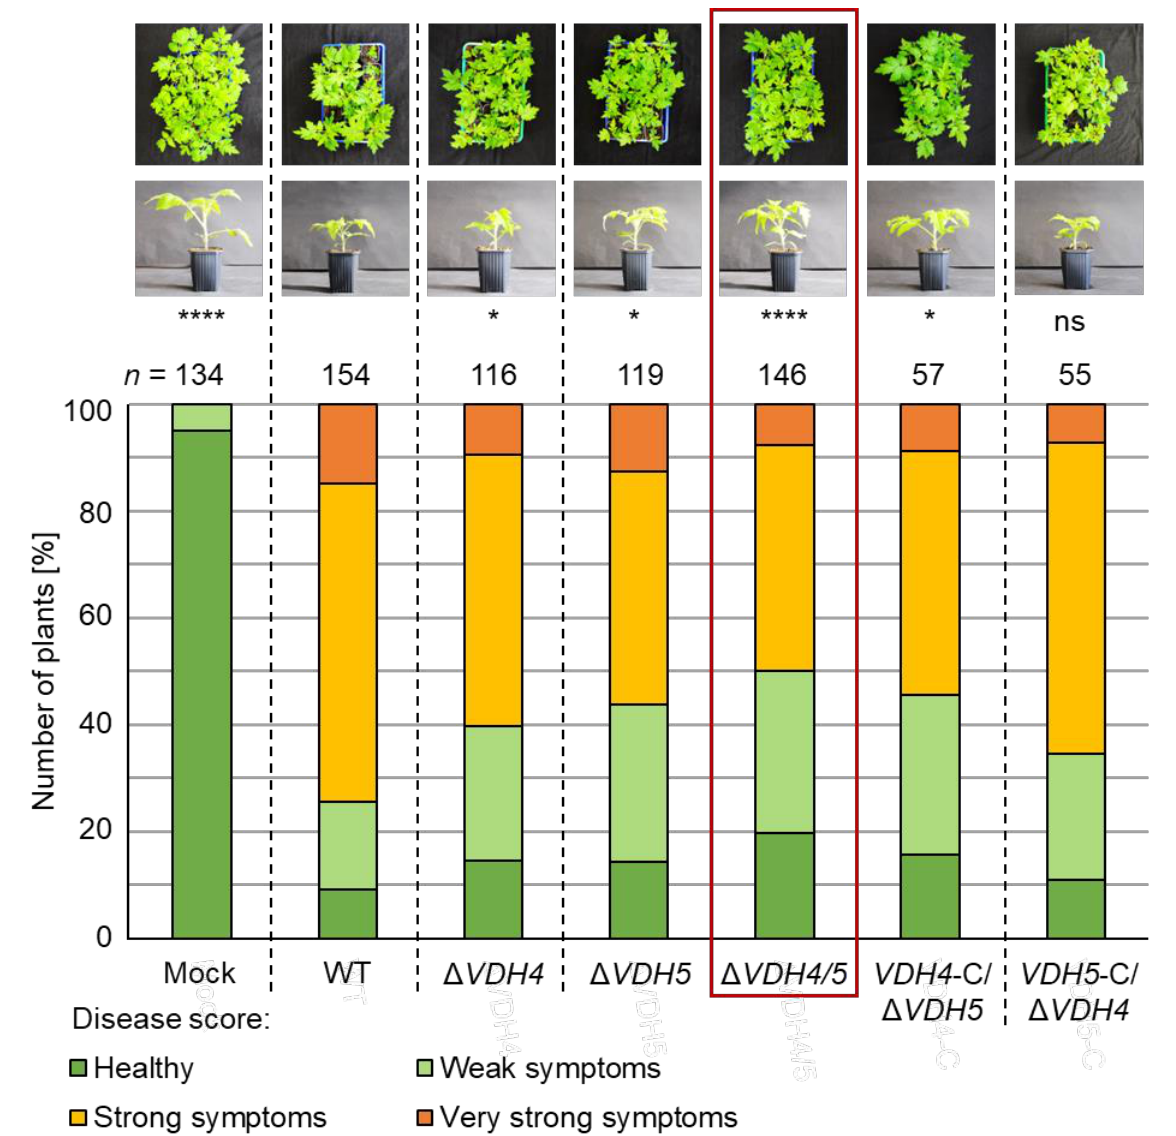
Figure 6. The presence of either VDH4 or VDH5 in V. dahliae is required for wild-type-like disease development in tomato plants. Tomato seedlings (ten-day-old) were inoculated with V. dahliae spores via root-dipping. JR2 wild-type (WT) or VDH4 ( ∆ VDH4 ), VDH5 ( ∆ VDH5 ), and VDH4/5 ( ∆ VDH4/5 ) deletion strains, or VDH4 ( VDH4 -C/ ∆ VDH5 ) and VDH5 ( VDH5 -C/ ∆ VDH4 ) single gene complementation strains in the double deletion strain background were used. Water-treated plants (mock) served as controls. Plants were incubated in a climate chamber at 16 h: 8 h light: dark at 22 – 25 °C. A general disease score was determined at 21 days after inoculation based on plant height, length of longest leaf, and plant weight ( n = number of treated plants). Plant overviews and a single representative plant per treatment are shown. Significant differences from wild-type were calculated using Mann–Whitney U tests. Infection by single deletion strains of VDH4 or VDH5 resulted in about 15–20% more plants displaying no or weak rather than strong disease symptoms compared with wild-type-infected plants (*, p < 0.05). With simultaneous deletion of both VDH4 and VHD5 , this effect was even stronger (****, p < 0.0001), as about 25% more plants were healthy or showed only weak disease symptoms (red box). Plants infected by the strain into which VDH4 was reintroduced ( VDH4 -C/ ∆ VDH5 ) displayed similar disease symptoms as plants treated with the single deletion strains. Plants infected by the VDH5 -C/ ∆ VDH4 strain were not significantly different from wild-type-infected plants (ns, not